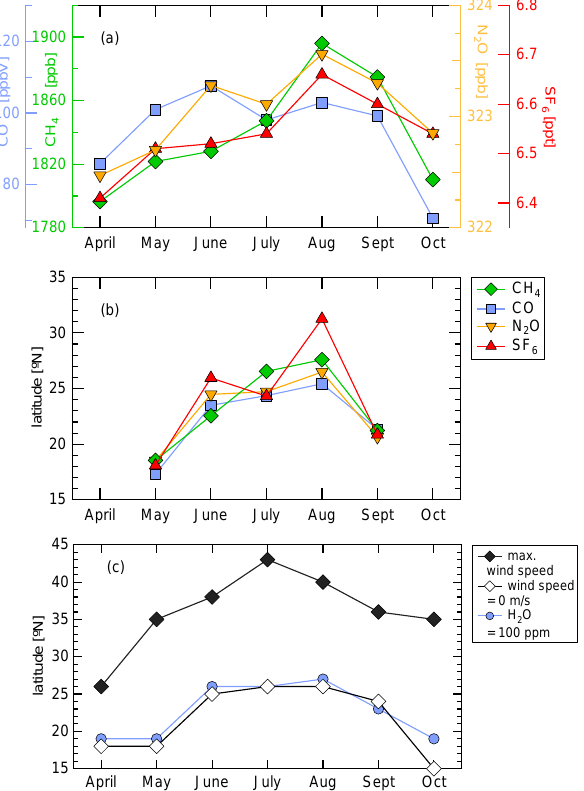
Fig. 7. (a) Maximum mixing ratios of CH 4 , CO, N 2 O, and SF 6 ob- served in summer 2008 south of 40 ◦ N. For April and October, when no monsoon plume is apparent, the monthly mean values are plot- ted. (b) Latitudinal position at which the maximum mixing ratios of CH 4 , CO, N 2 O, and SF 6 were observed. (c) Latitudinal position of the maximum wind speed in the westerly jet and the latitude where the zonal wind speed is 0m/s, both indicating the latitudinal posi- tion of the anticyclone. The latitude where a H 2 O mixing ratio of 100ppm is observed indicates the northern extension of the strong